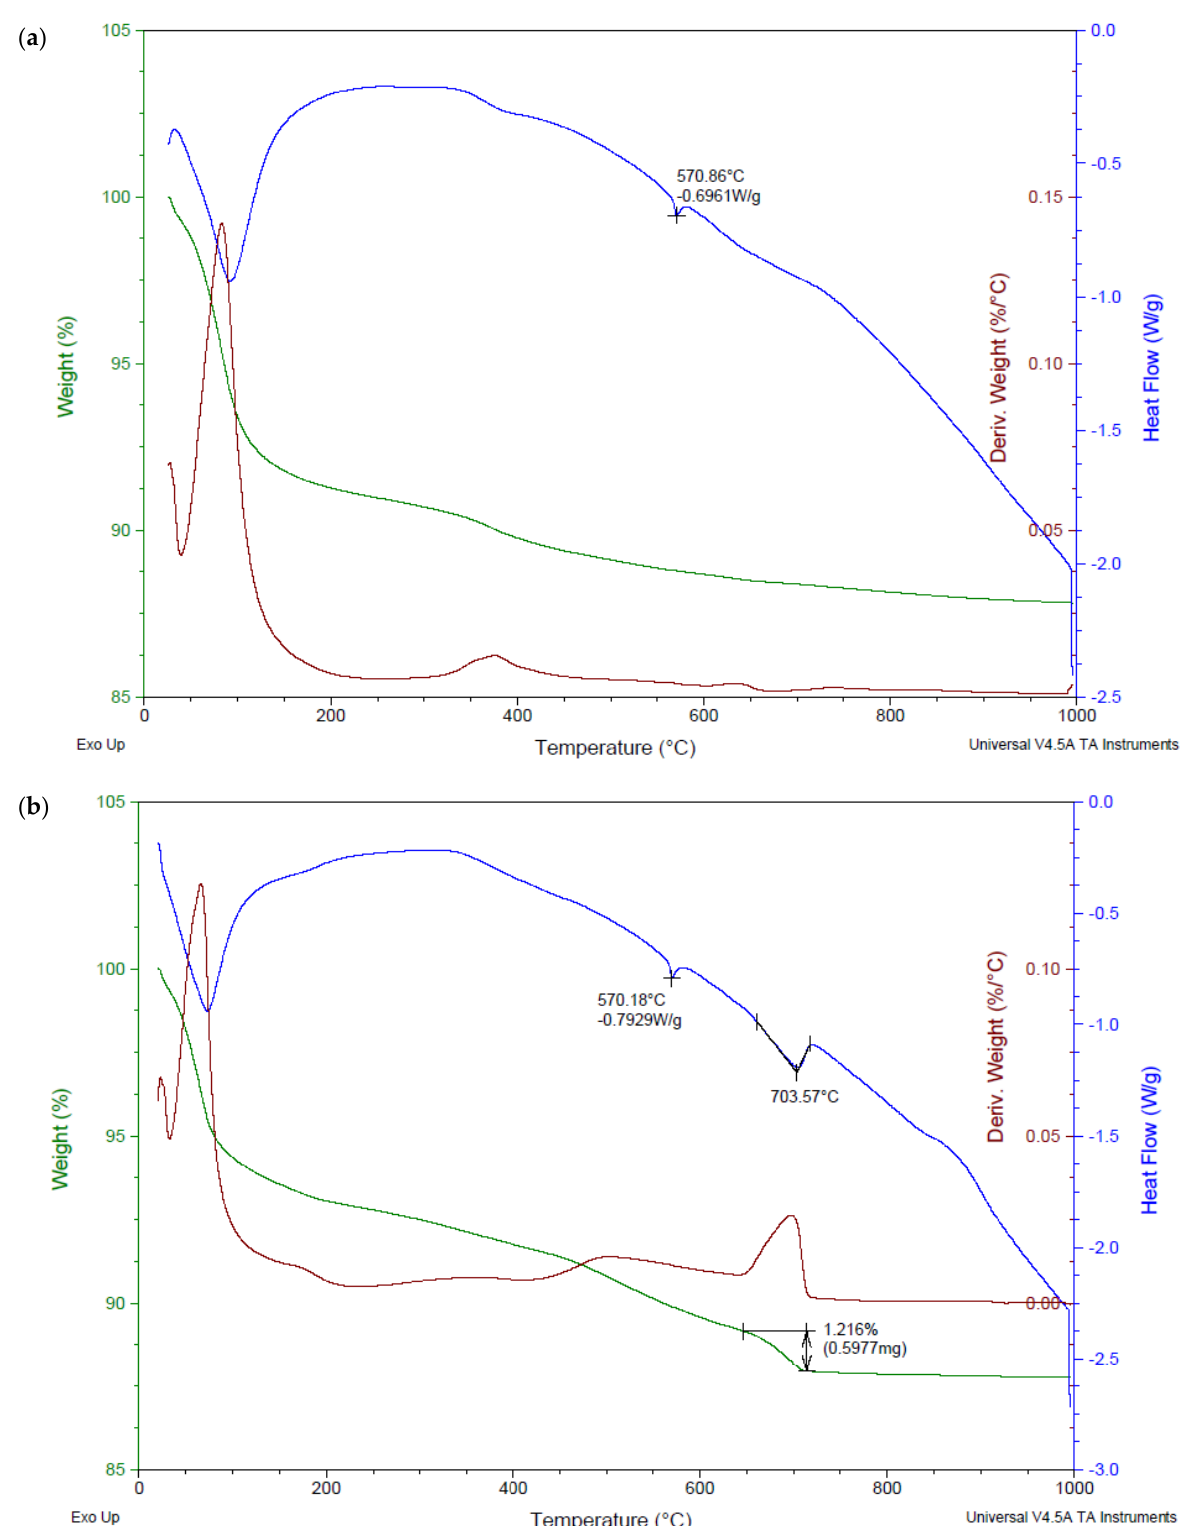
Figure 8. Thermal analysis REC 1 ( a ) indoor storage ( b ) in situ storage.